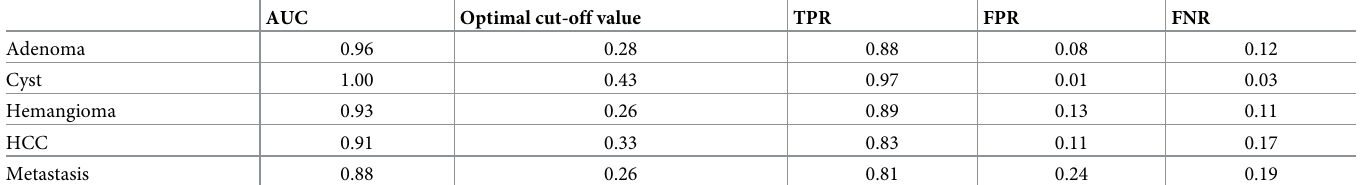
Table 5. Areas under the ROC curve (AUC) for each class including the optimal cut-off value and the corresponding true positive rate (TPR), false positive rate (FPR) and false negative rate (FNR). AUC Optimal cut-off